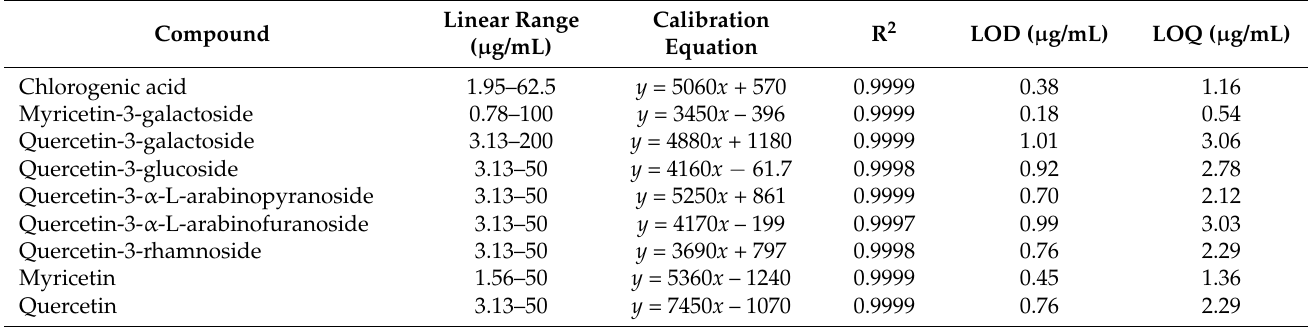
Table 2. Parameters of linearity, identification, and the limit of detection of the identified phenolic compounds.